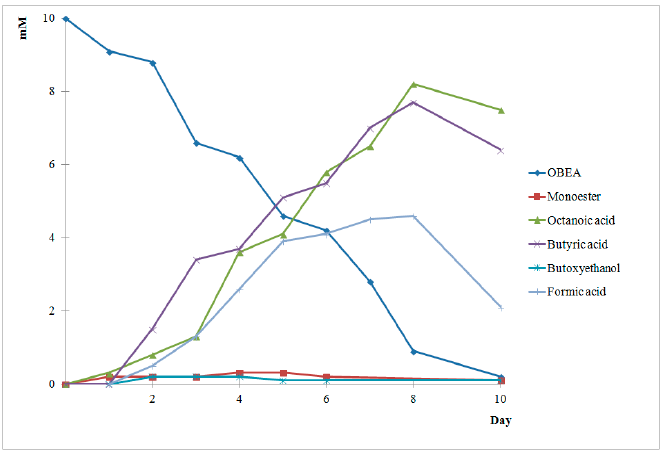
Figure 5. Biodegradation of OBEA in soil.